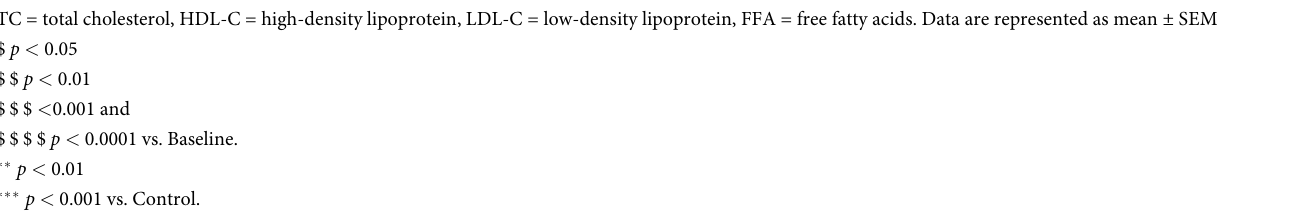
but not between the two groups (HFFD vs. Control) at the end of the protocol (12th week). Both weight and abdominal circumference parameters significantly (similarly) increased in both groups (12 th week vs. Baseline) (Table 1).